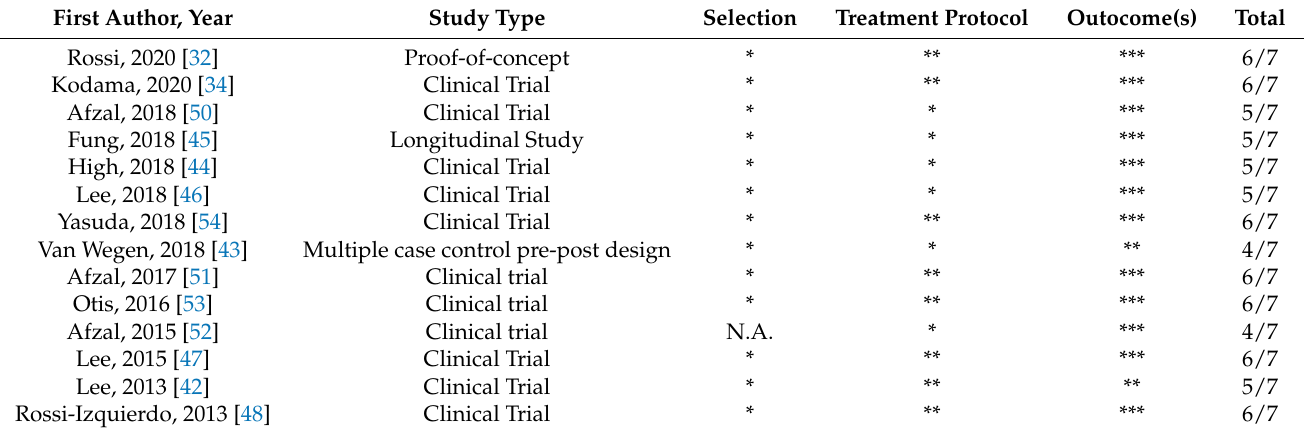
Table 2. Modified NOS scale scores of the included studies.